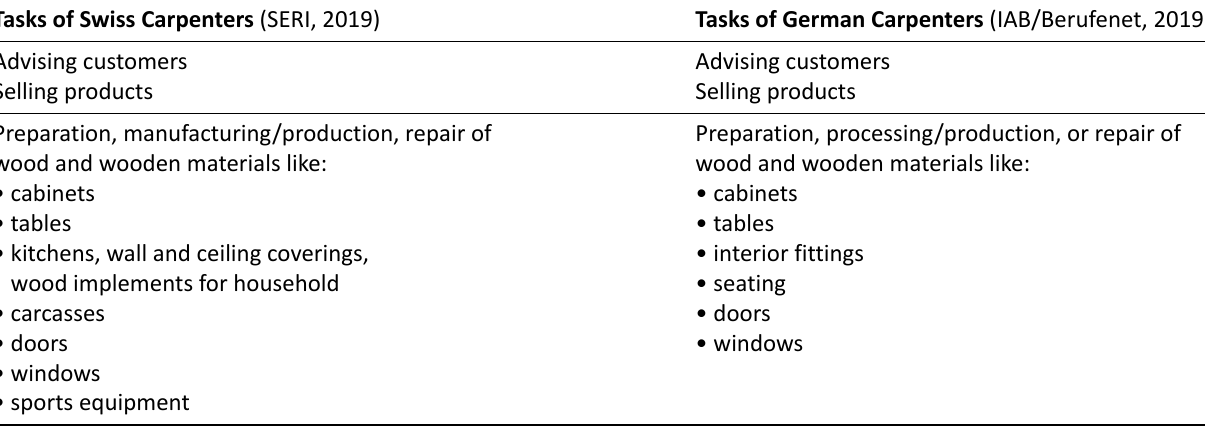
Table A4. Example of the similarity of Swiss and German occupations: Carpenter. Tasks of Swiss Carpenters (SERI,